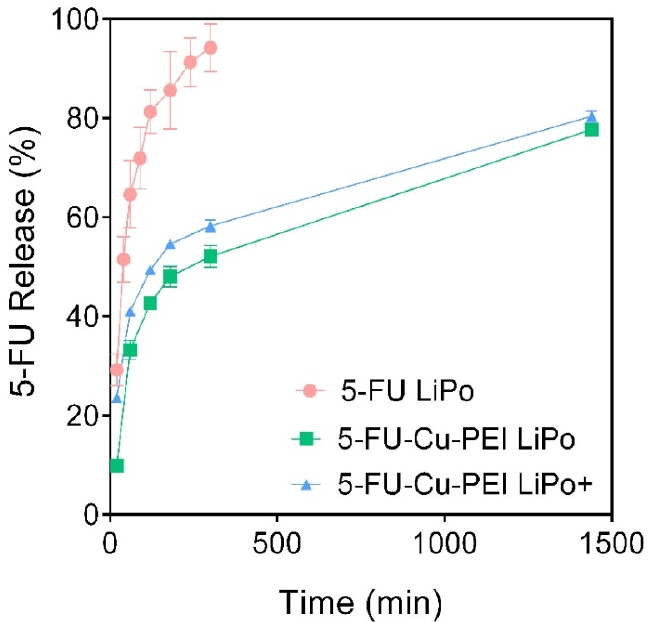
Figure 2. In vitro 5-FU release from 5-FU LiPo (red circles), 5-FU-Cu-PEI LiPo (green squares), and 5-FU-Cu-PEI LiPo+ at pH 7.4, 37 °C. Data represent mean ± S.D. ( n = 3).